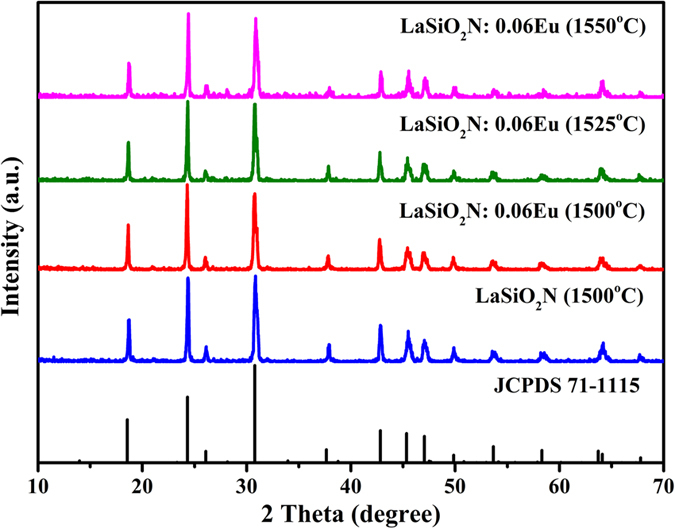
XRD patterns of as-synthesized LaSiO2N:Eu phosphors, LaSiO2N host and the standard pattern (JCPDS 71–1115) of LaSiO2N.